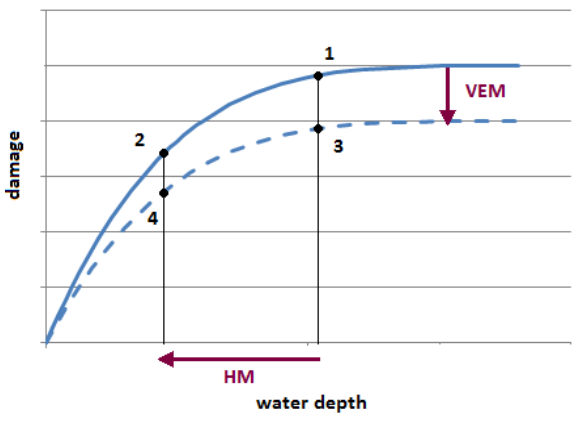
Fig. 2. Effect of hazard mitigation (HM) and vulnerability and ex- posure mitigation (VEM) on potential Figure 2. Effect of hazard mitigation (HM) and vulnerability and exposure mitigation (VEM) 3 on potential damages. 4